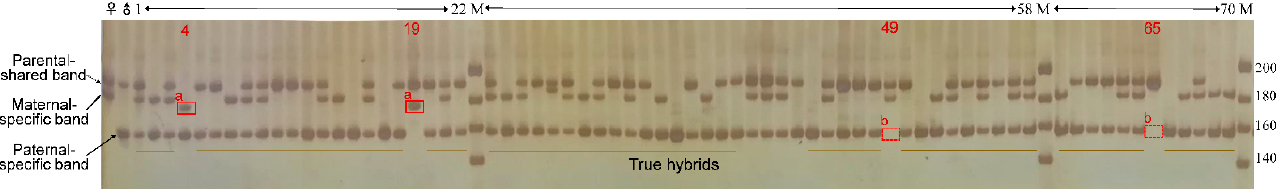
Figure 4. Banding patters based upon SSR marker SAUCps706 among F 1 individuals derived from the cross population of NZH×HF. ♀ : female parent; ♂ : male parent; M: DNA marker. 1–70 represented part of the F 1 individuals, no. 4 and no. 19 showed foreign origins, and no. 49 and no. 65 were maternal-type individuals. a: Non-parental shared, maternal-specific band, or paternal-specific band; b: the absence of paternal-specific band.